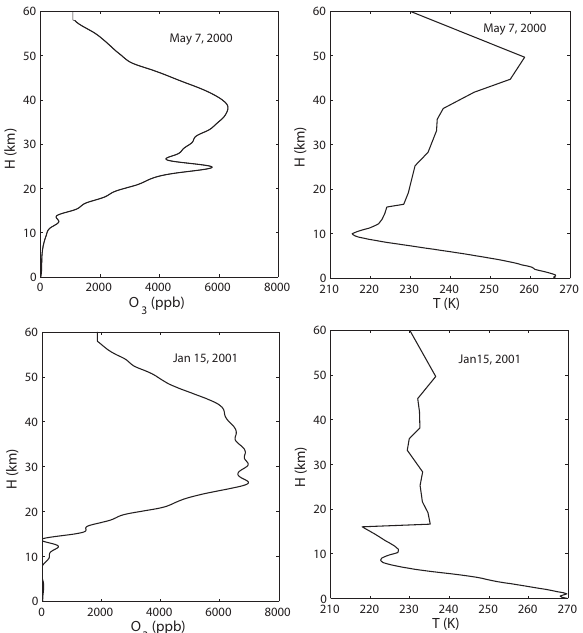
Fig. 9. Ozone (left) and temperature (right) profiles at Barrow, Alaska, obtained on 7 May 2000 (above) and 15 January 2001 (be-